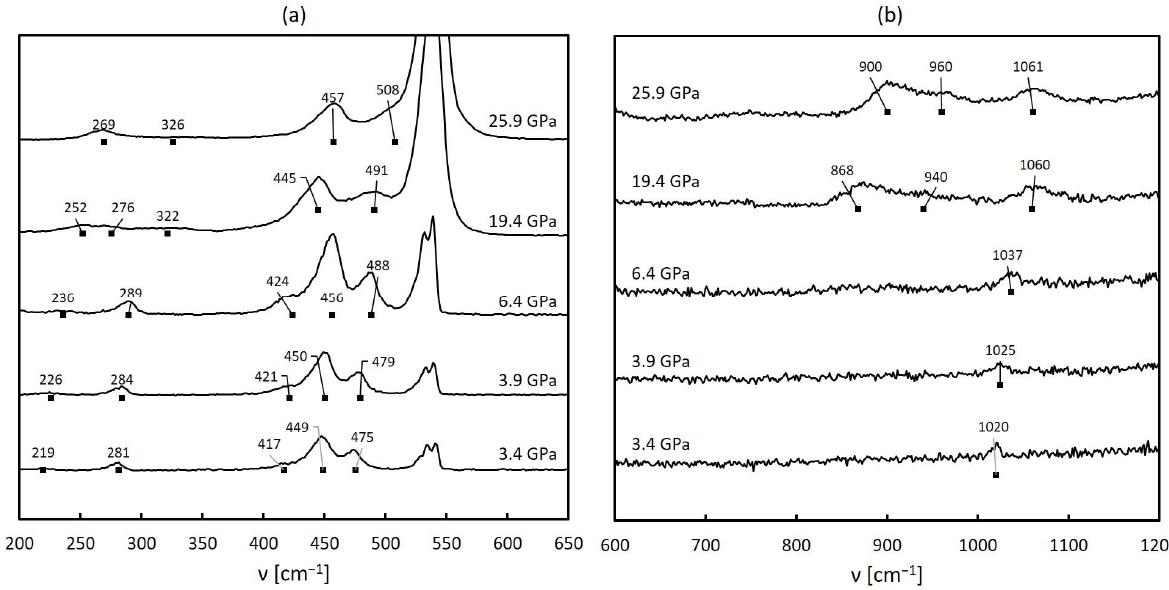
Figure 3. Comparison of spectra obtained in experiment B. Ag + Cl 2 mixture compressed initially to ca. 3 GPa. ( a ) 200–650 cm − 1 range, ( b ) 600–1200 cm − 1 range. See text for further details.